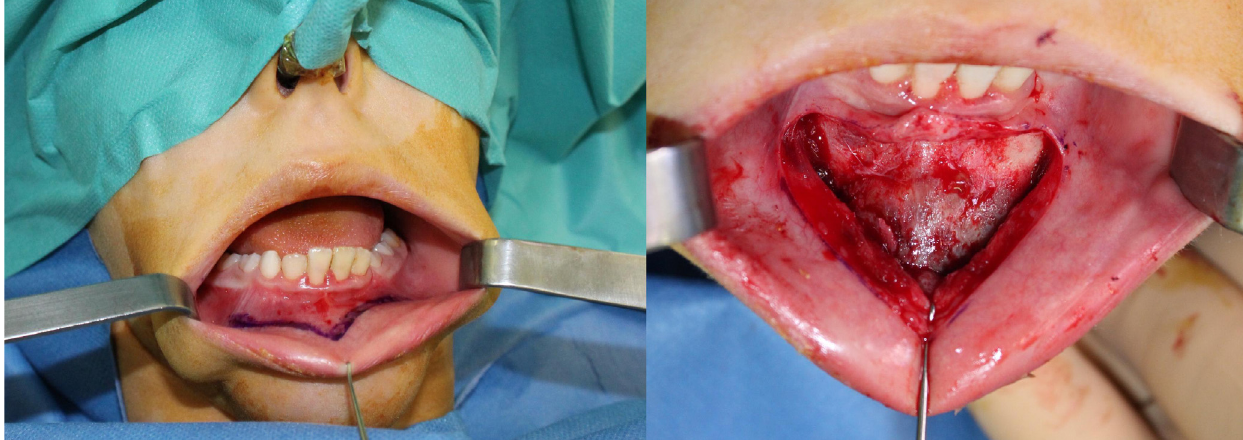
Fig. 3. Left: vestibular layout. Right: lesion exposure (still surrounded by a thin bone fi lm) after subperiosteal elevation.